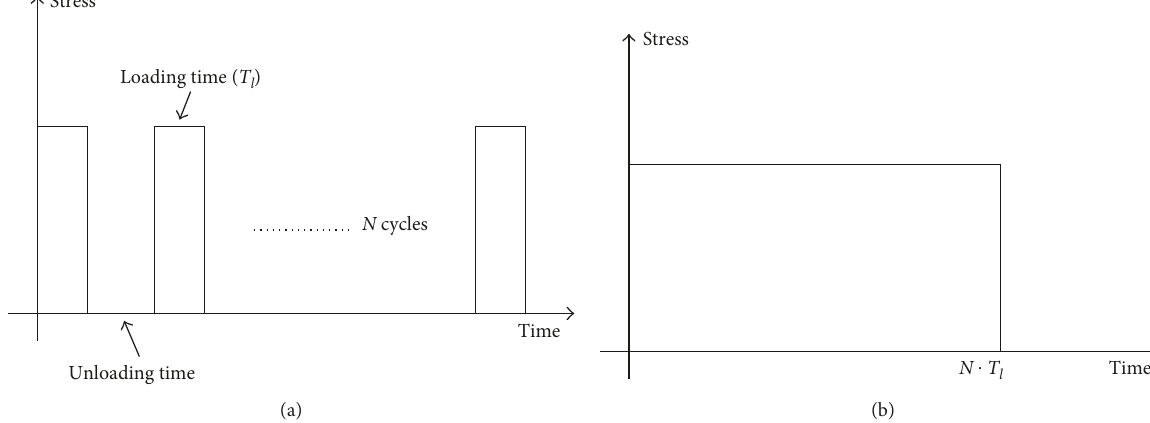
Figure 10: The sketch of two loading modes. (a) Pulse loading mode and (b) equivalent loading mode.